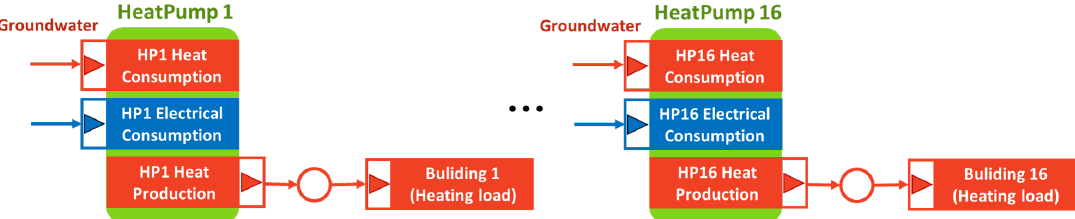
Figure 12. Modeling of the energy system of the second study case (16 buildings and 16 heat pumps) according to OMEGAlpes